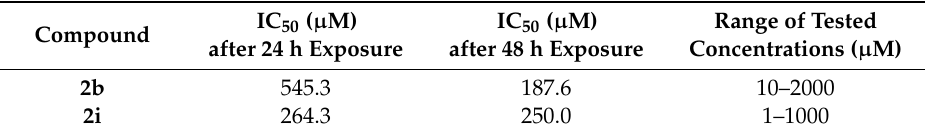
Table 5. Prolonged cytotoxicity in HepG2